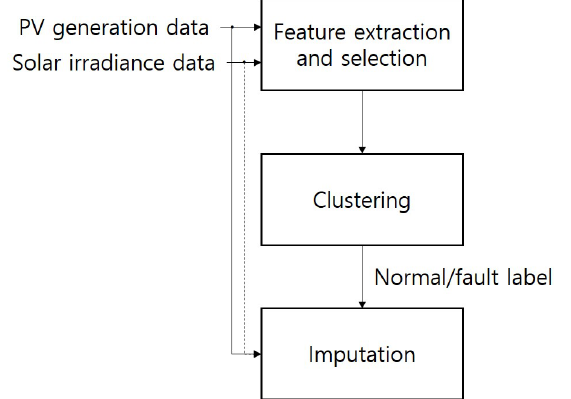
Figure 3. Overall architecture of the proposed